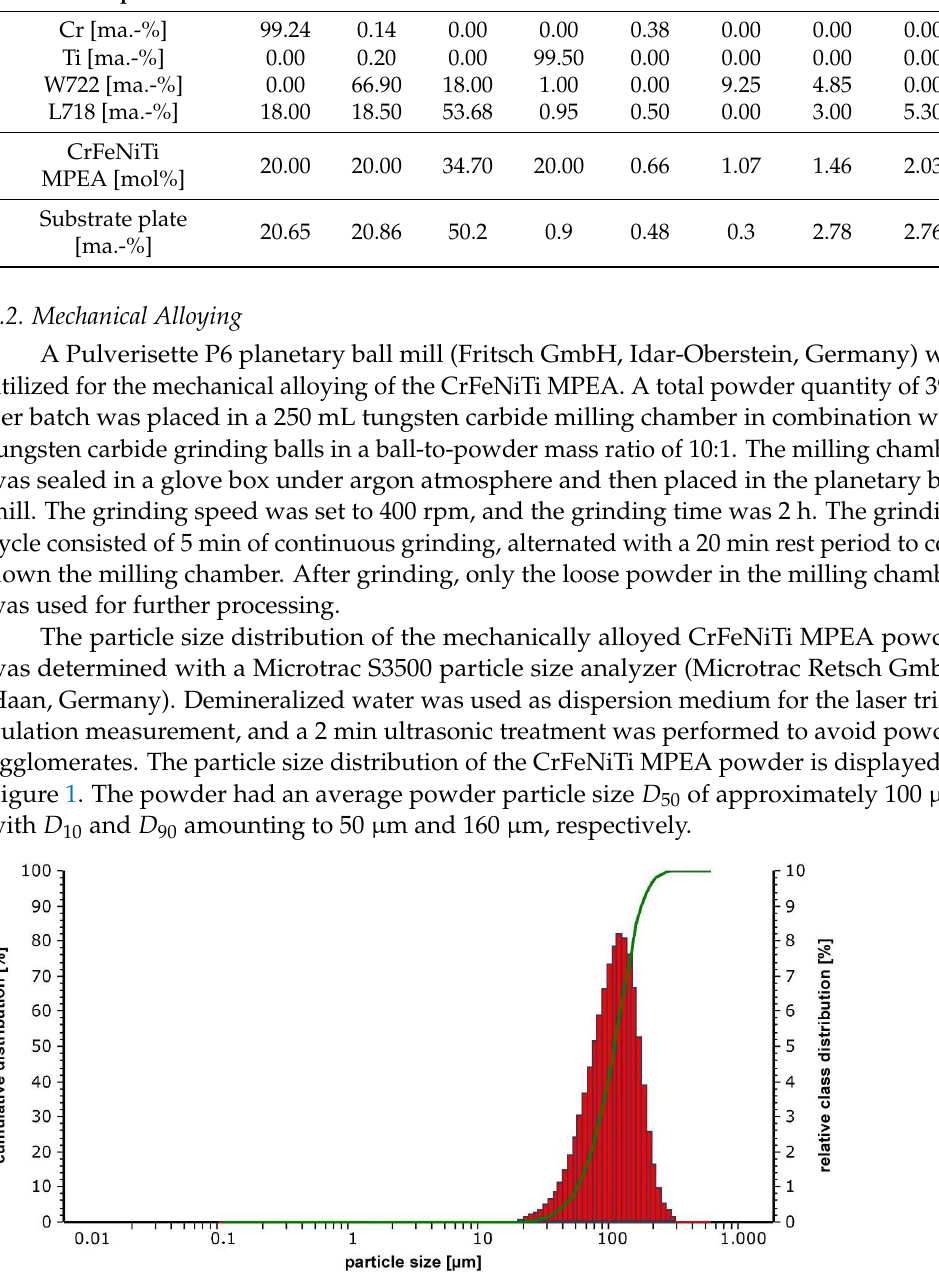
Figure 1. Particle size distribution of the mechanically-alloyed CrFeNiTi MPEA powder: the green curve shows the cumulative particle size distribution ranging from 0% to 100%; the red bars represent the relative percentage of the particle size